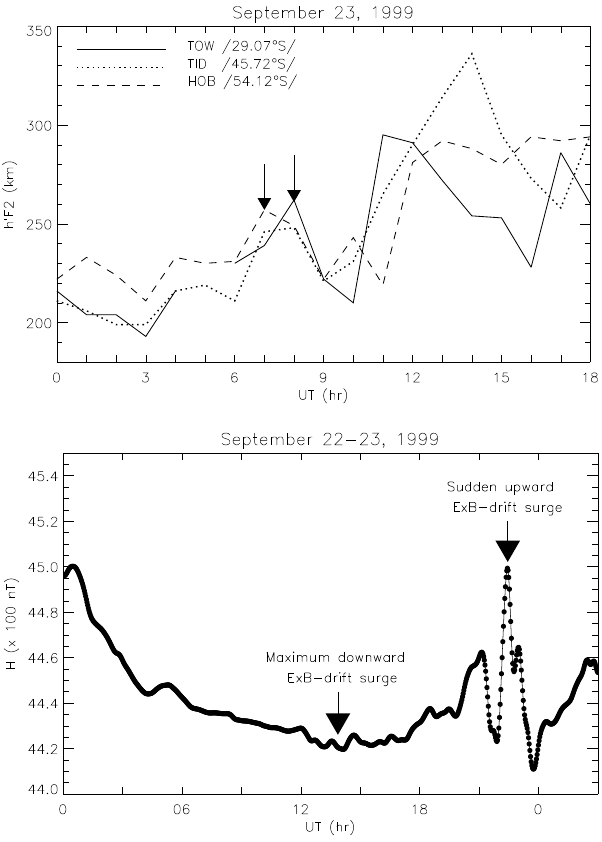
Fig. 7. ( a ) An hour interval virtual F-region height ( h 0 F ) adopted from ionsonde data recorded at the three stations (Townsville, Tid- binbilla, and Hobart) on 23 September. ( b ) The 1H (difference be- tween the horizontal component of the geomagnetic field (H) at the equator and at non-equator regions) obtained from the magnetome- ter data at Hatizyo (23.46 ◦ N, –152.18 ◦ E geomagnetic) and at Guam (4.57 ◦ N, –145.24 ◦ E geomagnetic) to estimate vertical E × B